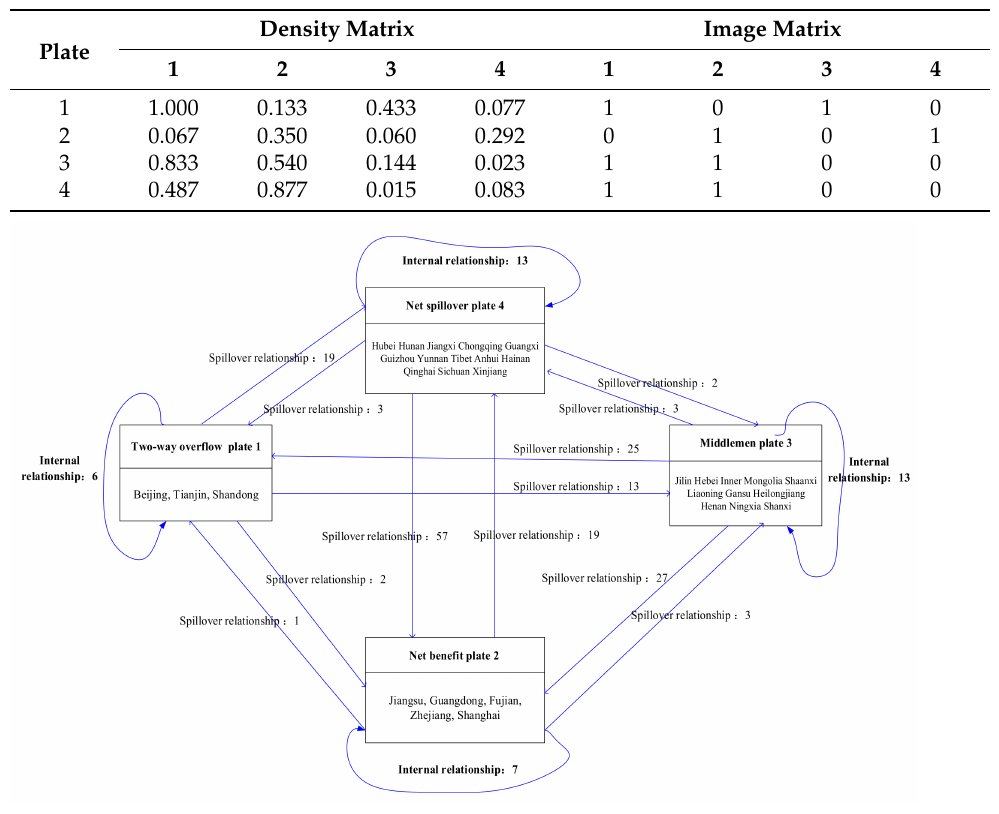
Table 8. Density matrix and image matrix of each section of China’s agricultural science and technology resource allocation efficiency spatial correlation network.